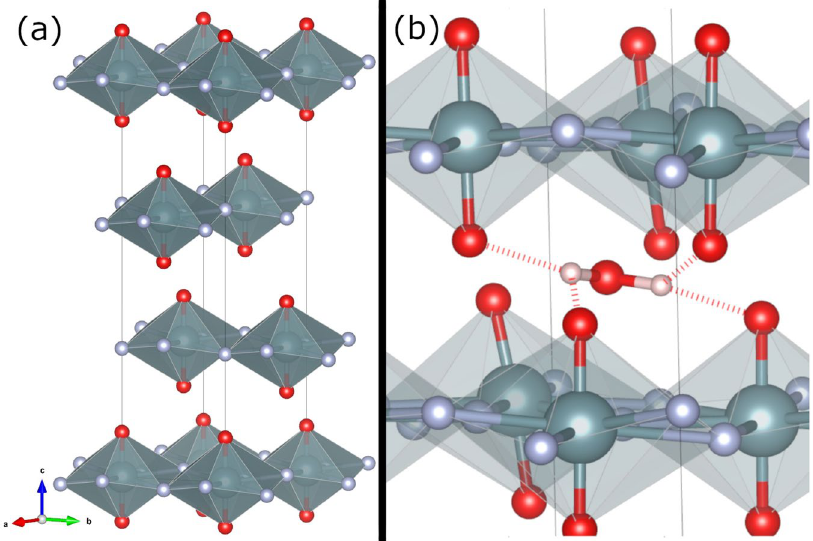
Figure 1. Structure of anhydrous UO 2 F 2 (U = teal, O = red, F = grey). Panel (a), hexagonal unit cell of UO 2 F 2 with three-layer repeat structure. Panel (b), relaxed interlayer position of adsorbed water molecule (H = pink), with hydrogen bonds shown. H atoms form strong H-bonds (dashed bonds) with uranyl oxygens (two at 1.81 Å and two at 2.09 Å). Interactions between the water oxygen and neighbor uranyl units result in a O–U–O angle of